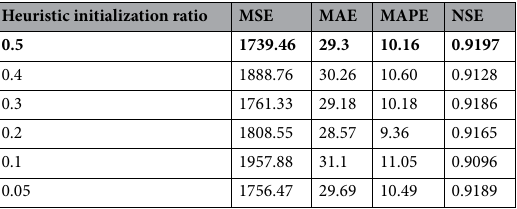
Heuristic mutation